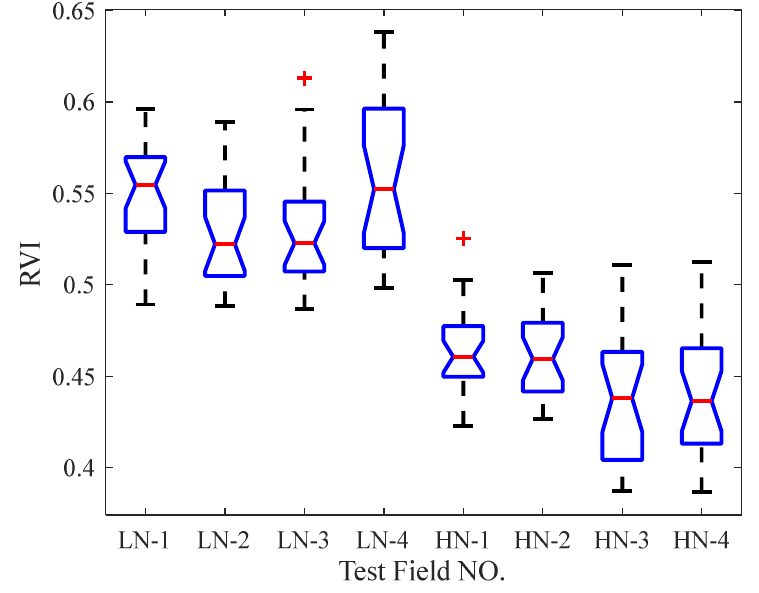
Figure 18. Boxplot of RVI values in test fields with different nitrogen application rate levels. Table 4. Results of multiple comparison tests for NDVI and RVI.